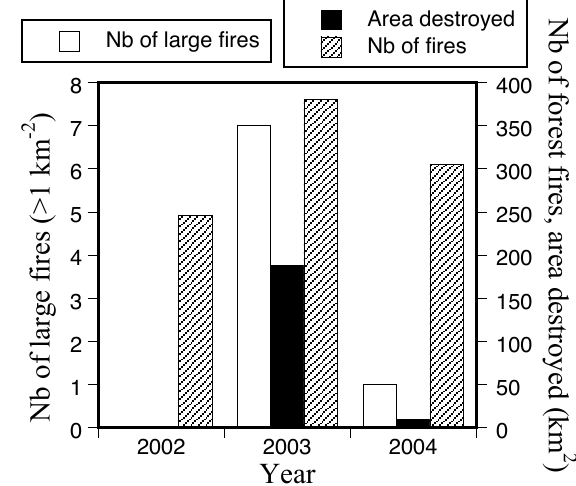
Fig. 4. Frequency of forest fires in the Var Department. The Var De- partment is in the West of the study site. In summer mainly westerly winds occur. Forest fires occurred almost exclusively during July and